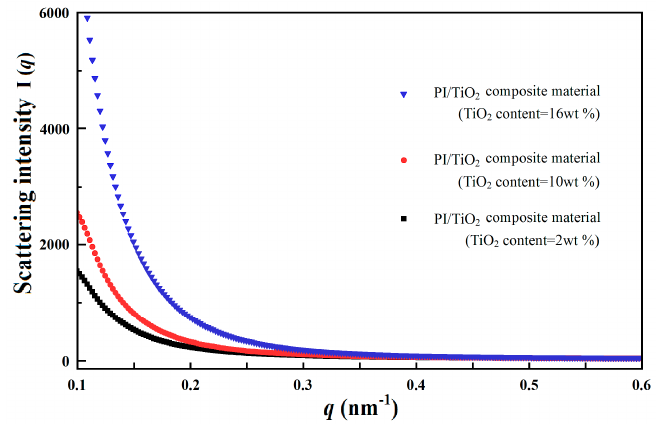
Figure 4. Small angle X-ray scattering (SAXS) experimental data for the PI/TiO 2 composite material with different TiO 2 contents.